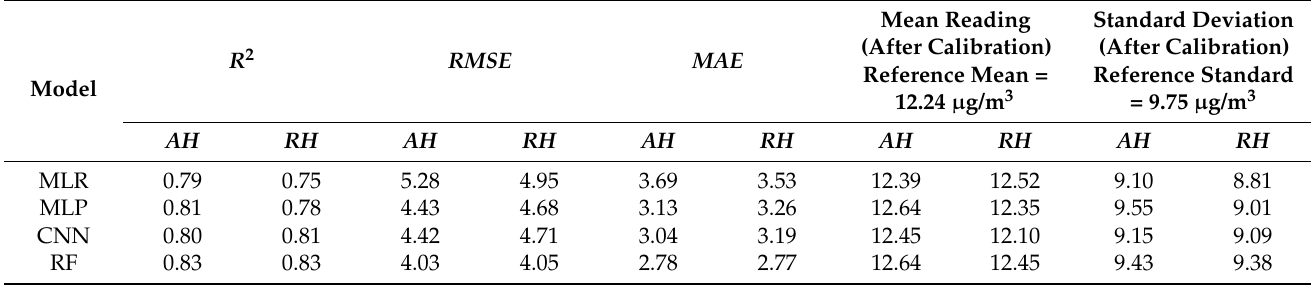
Table 3. Statistical performance measures analysis for PM 10